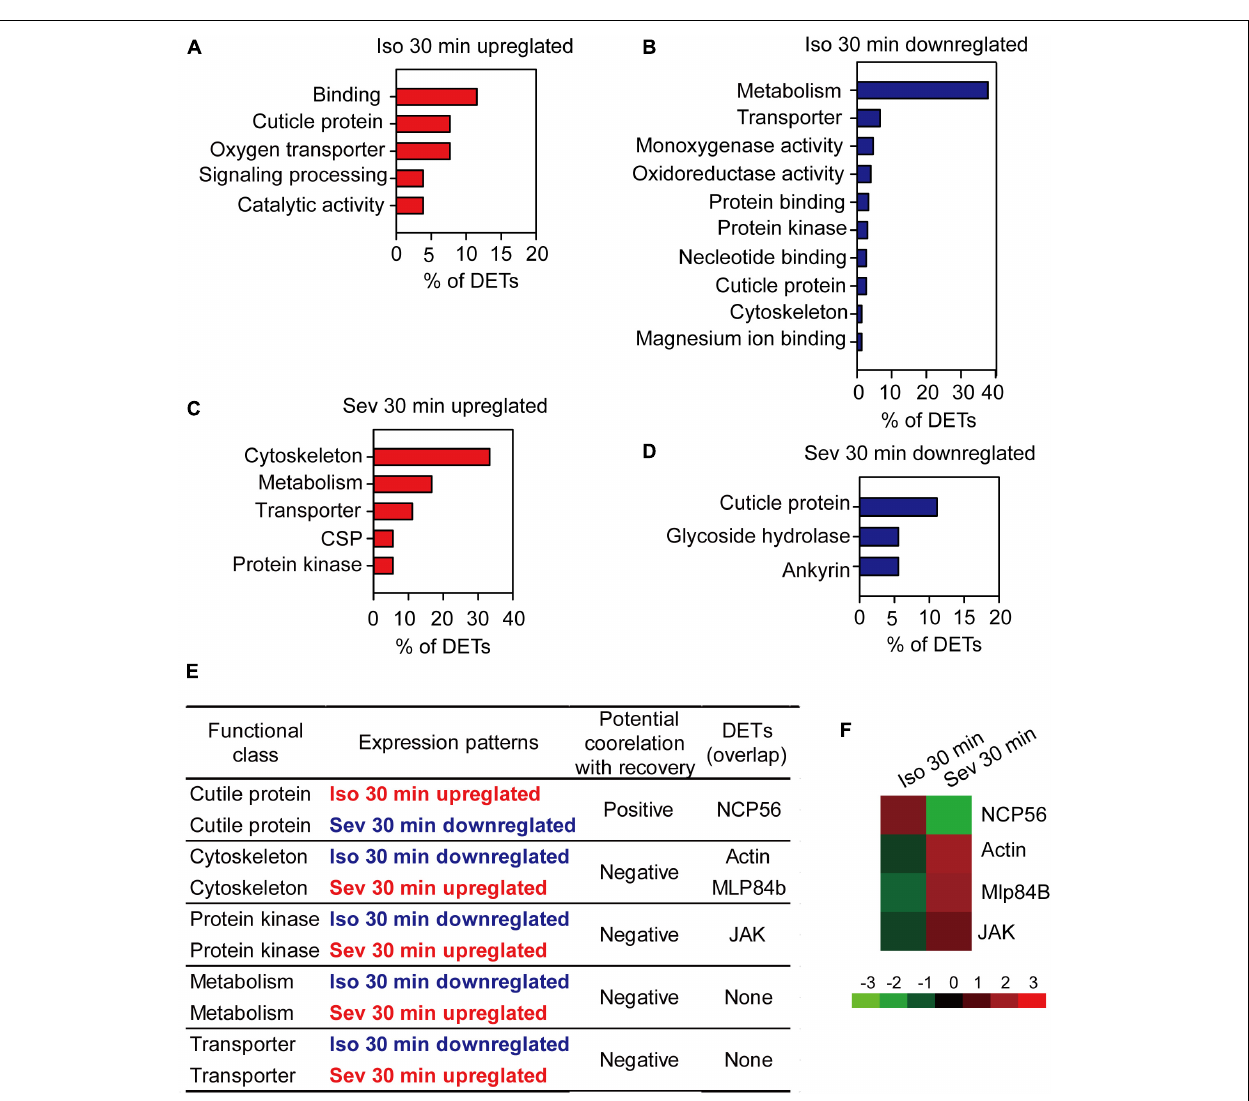
within 10 min after discontinuing anesthesia ( Figures 7A,C,E